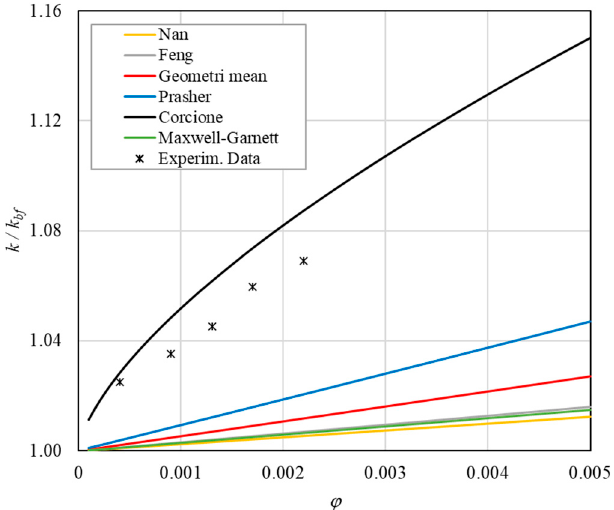
Figure 13. Increase in thermal conductivity versus volumetric content for engine oil (Castrol Mag- natec 10W40)—Alumina (d = 50 nm) at 60 °C.